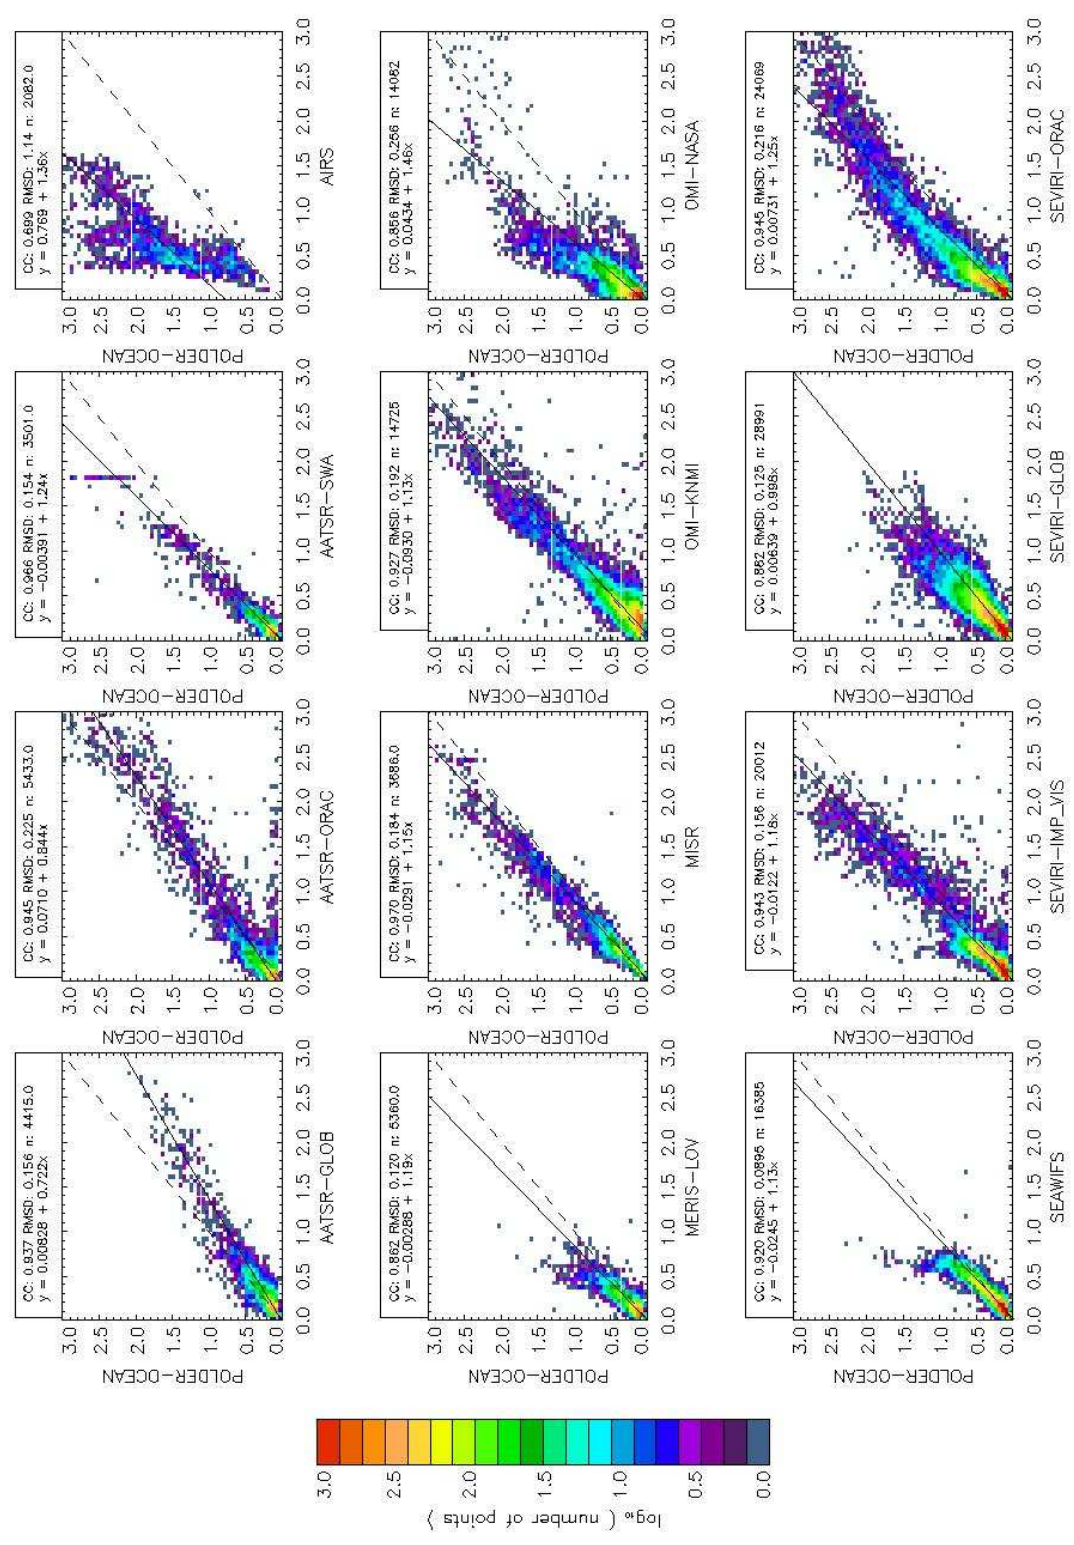
Fig. 7. Example of scatter plots over ocean, POLDER-OCEAN vs. other datasets. In every scatter plot, there is a caption: the first line indicates the correlation coefficient (CC), the root-mean-square differences (RMSD) and the number of coincidences ( n ); the second line presents the best linear fit.